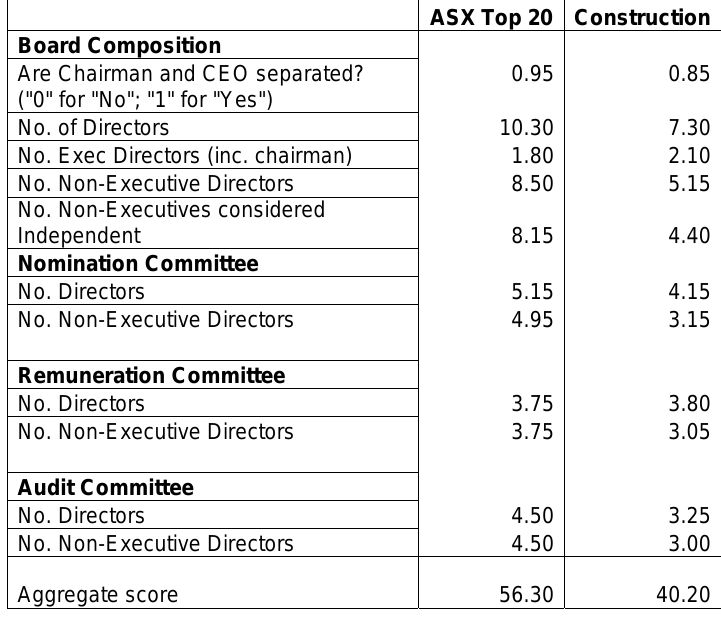
Table 4: Comparisons of average results for characteristics of the board of directors and board committees between ASX Top 20 and